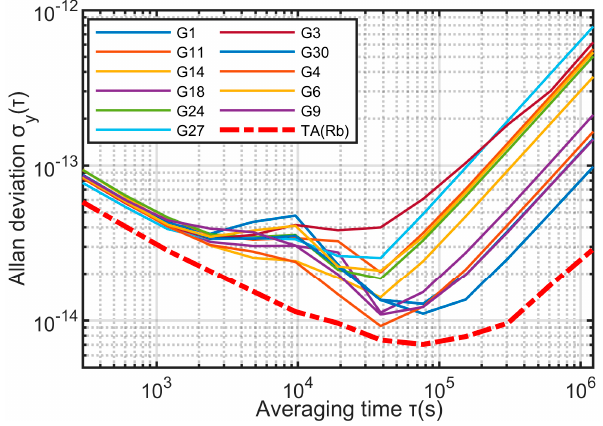
Figure 4. Frequency stability of rubidium clock group.